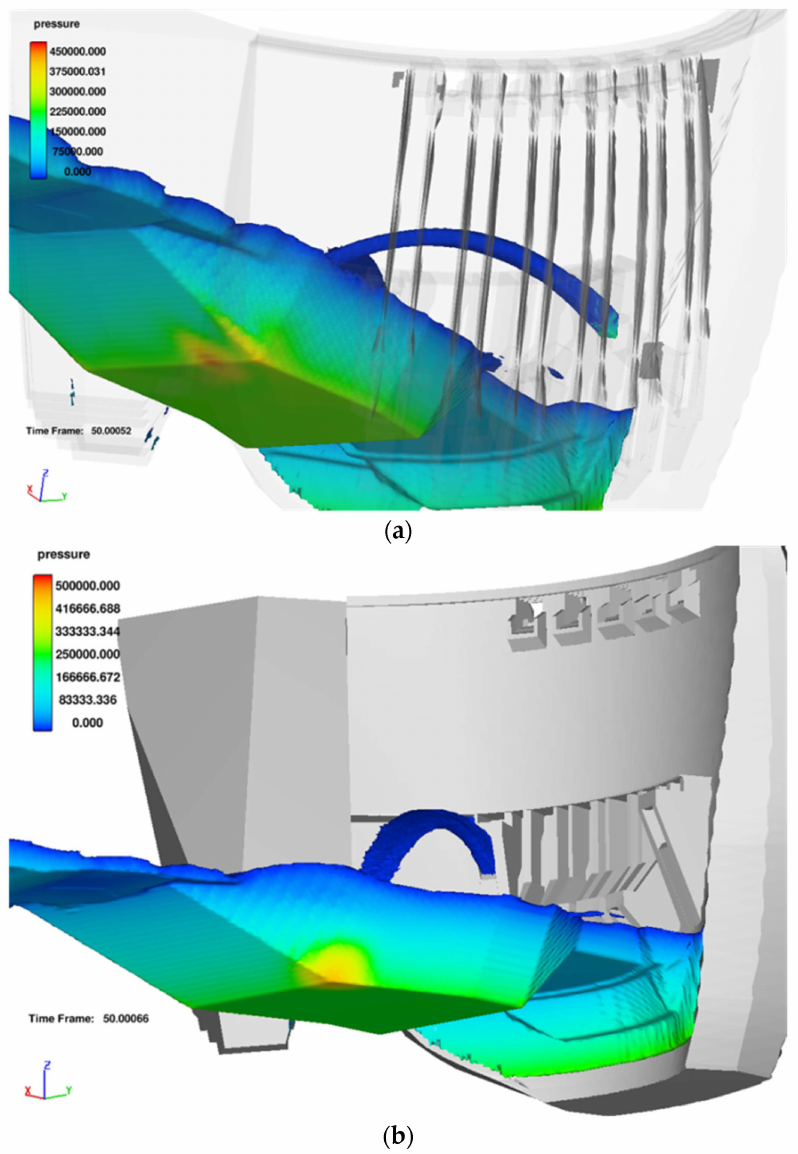
Figure 16. Spatial views of pressures in the pre-excavated stilling basin (Prototype scale. Units in Pascal): ( a ) Working two ducts of half-height outlet ( Q = 1760 m 3 /s); ( b ) Working one duct of half-height outlet ( Q = 880 m 3